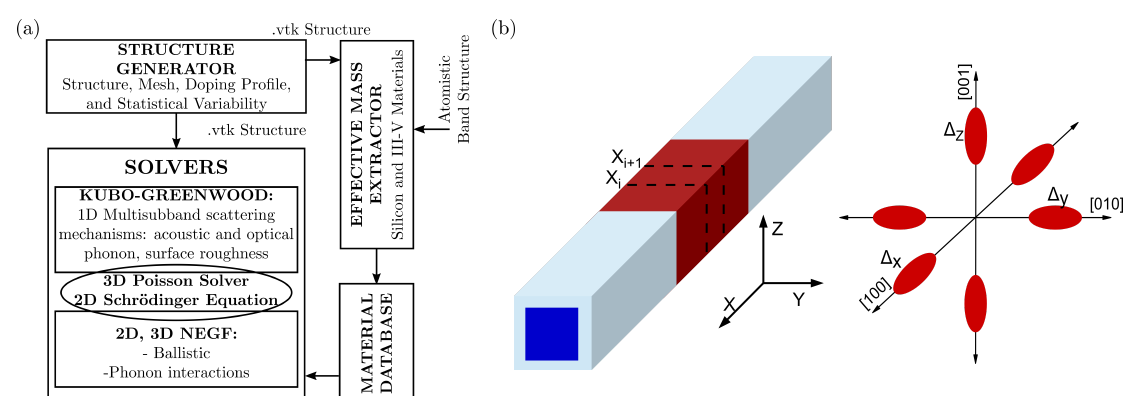
Figure 1. ( a ) Flowchart of the simulator NESS including the modules herein used. ( b ) Schematic of a simulated nanowire device along with the doubly-degenerate ∆ valleys used in the